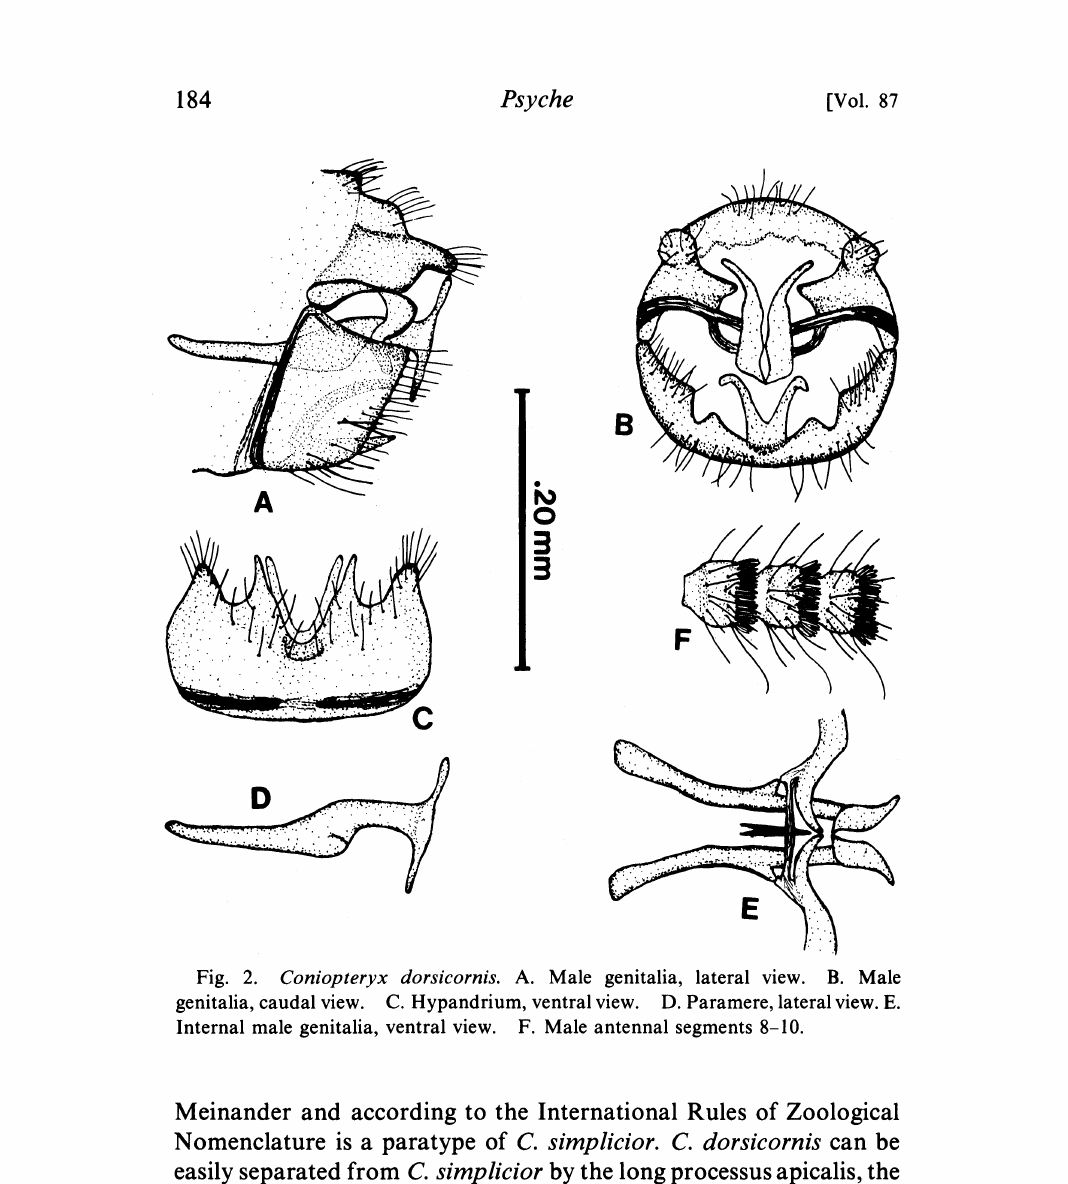
Fig. 2. Coniopceryx dorsicornis. A. Male genitalia, lateral view. B. Male genitalia, caudal view. C. Hypandrium, ventral view. D. Paramere, lateral view. E. Internal male genitalia, ventral view. F. Male antennal segments